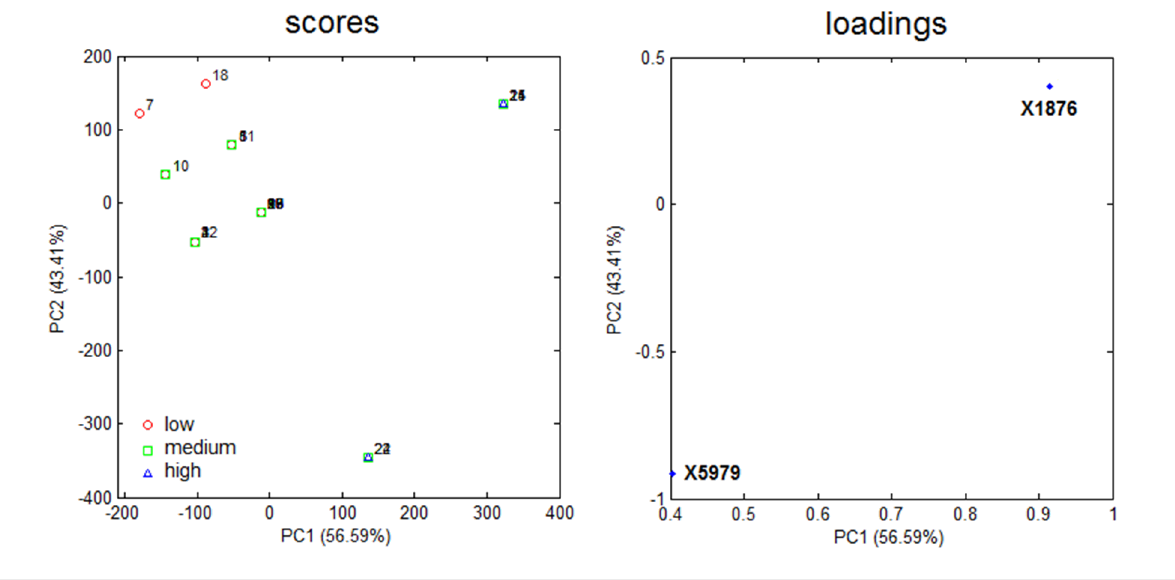
tional search inside a receptor normally gives the mode of inter- action between substrate and enzyme, as well as the intermolec- ular interaction energy (related to the ligand–receptor affinity and, consequently, to the bioactivity), further QSAR analysis would be of limited